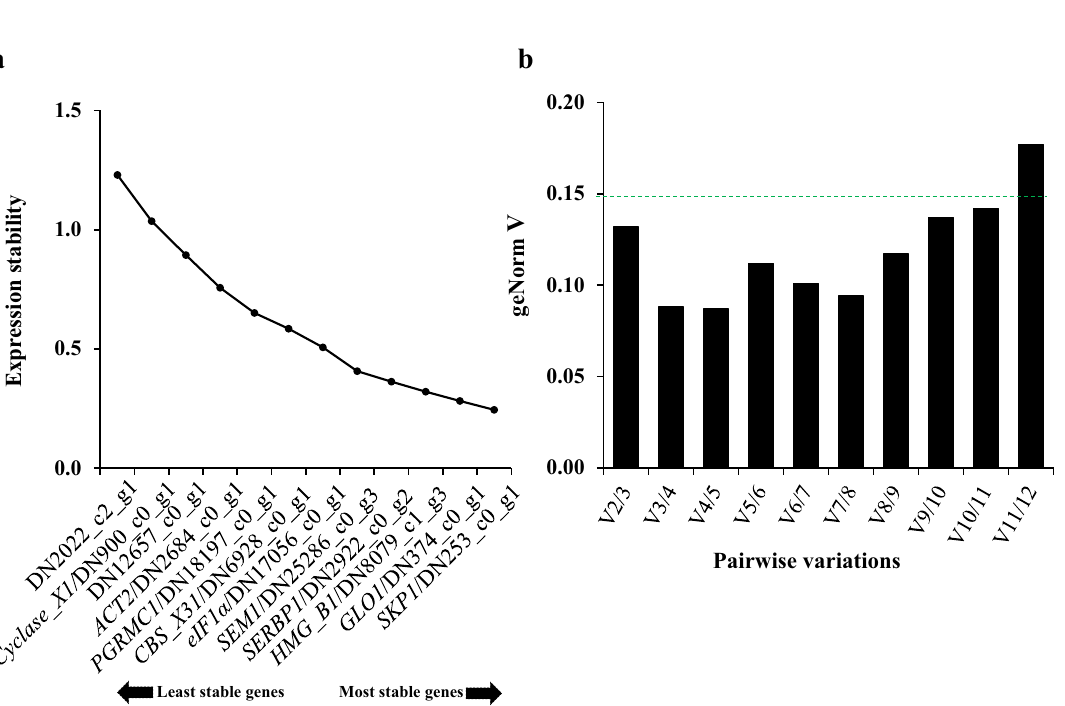
Figure 4. geNorm analysis of candidate RGs and controls. ( a ) Stability rankings of candidate reference and control genes based on the M values calculated by the geNorm algorithm. ( b ) Determination of the optimal number of reference genes for qRT-PCR normalization in different tissues. The variation value V was calculated by the geNorm algorithm. The default value of 0.15 (blue dash line) was taken as the